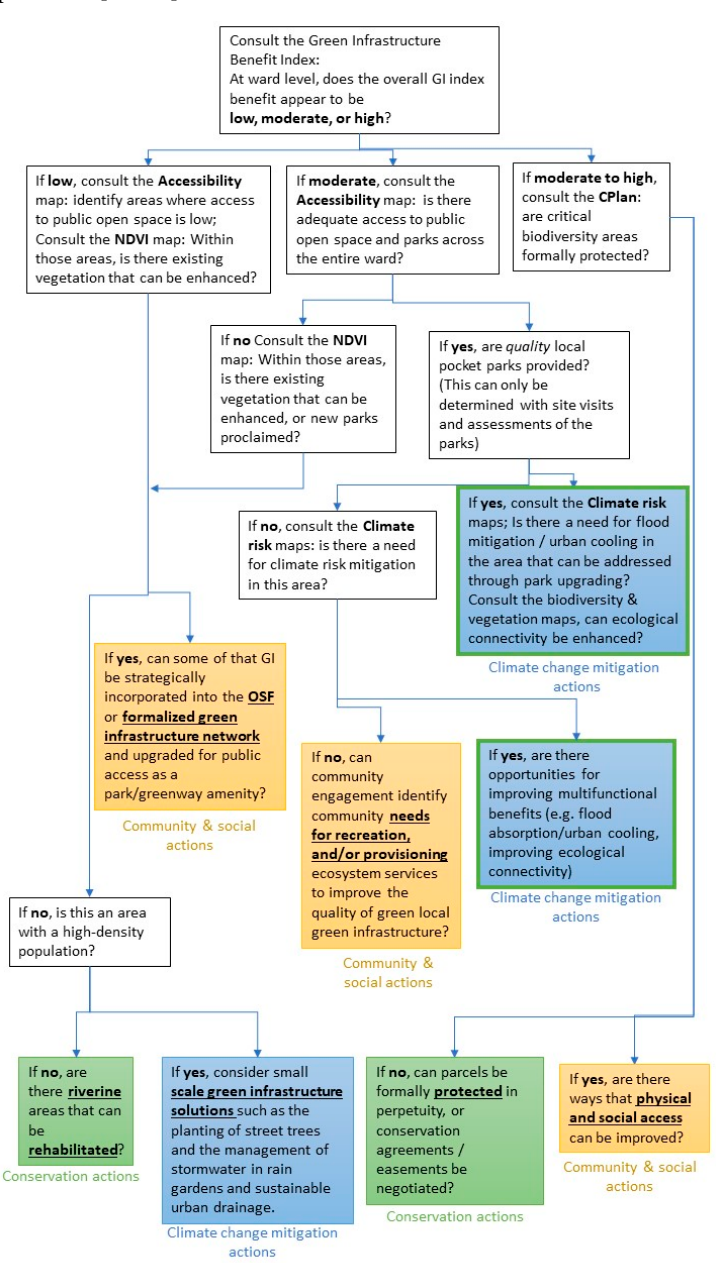
Figure 6. An example of a decision tree for guidance on selecting from the alternative development activities which can be implemented in response to the information in the green infrastructure benefit index map.